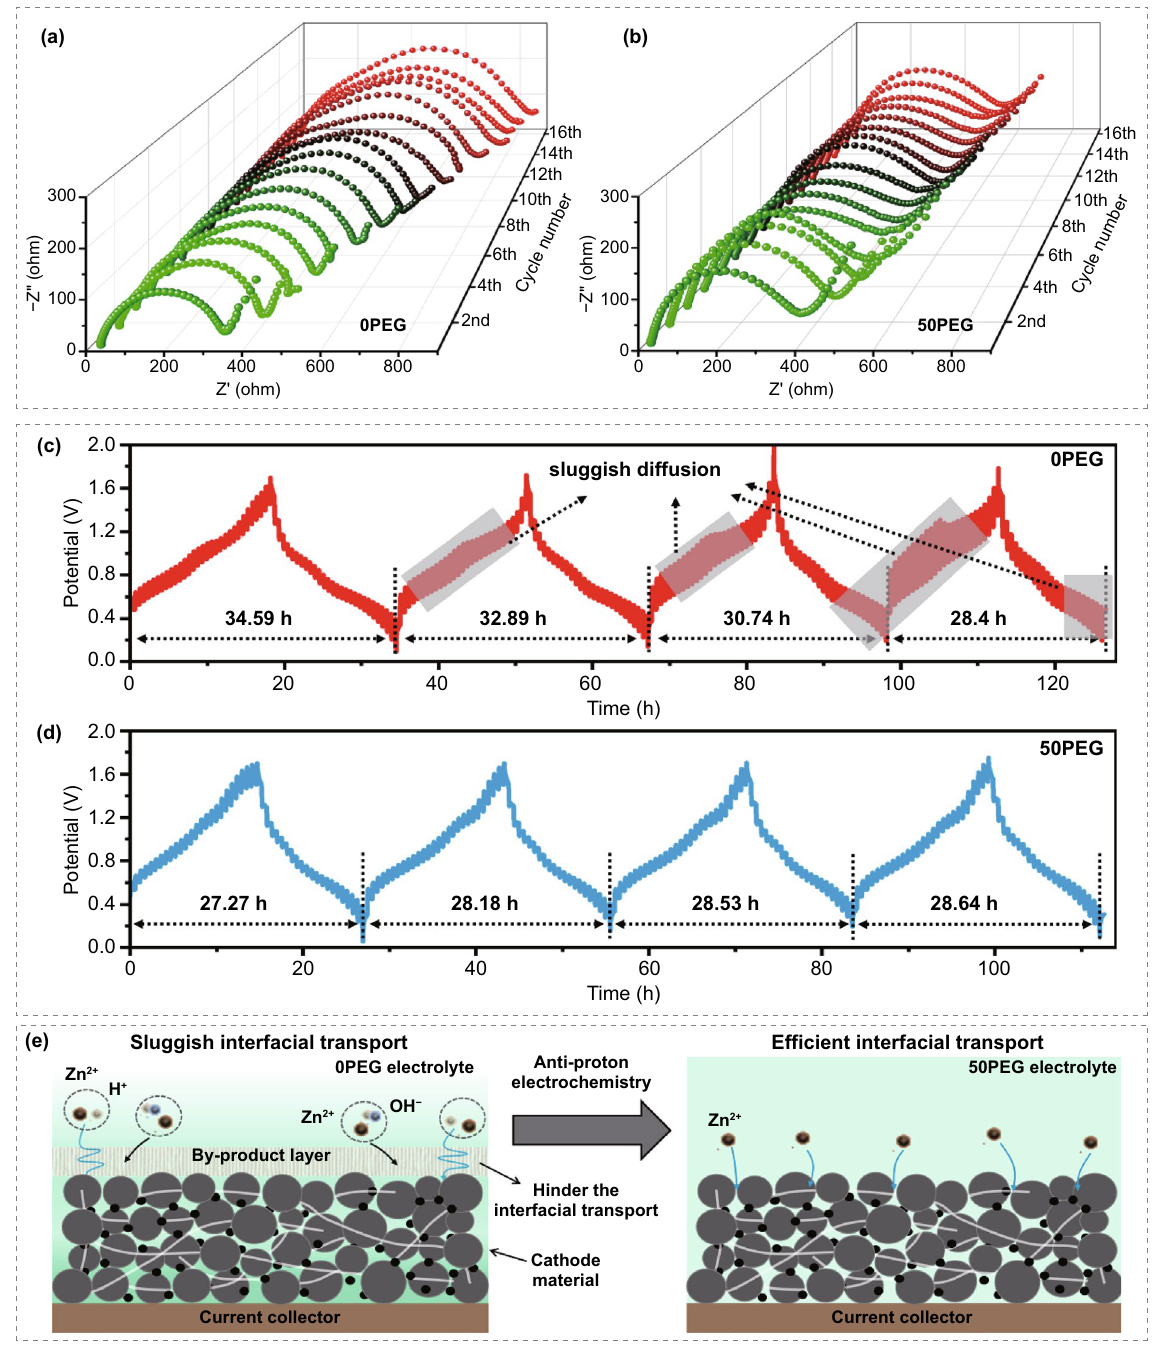
Fig. 6 In-situ electrochemical impedance spectroscopy (EIS) test of the V 2 O 3 /C electrode in a 0PEG and b 50PEG electrolyte during the initial 16 cycles, at the current density of 0.5 A g −1 . The Galvanostatic Intermittent Titration Technique (GITT) of V 2 O 3 /C electrode cycled in c 0PEG electrolyte and d 50PEG electrolyte with a 0.2 A g −1 pulse current density, 5 min pulse time and 30 min relaxation time. e The evolution of interfacial transport kinetics of electrode regulated by the anti-proton